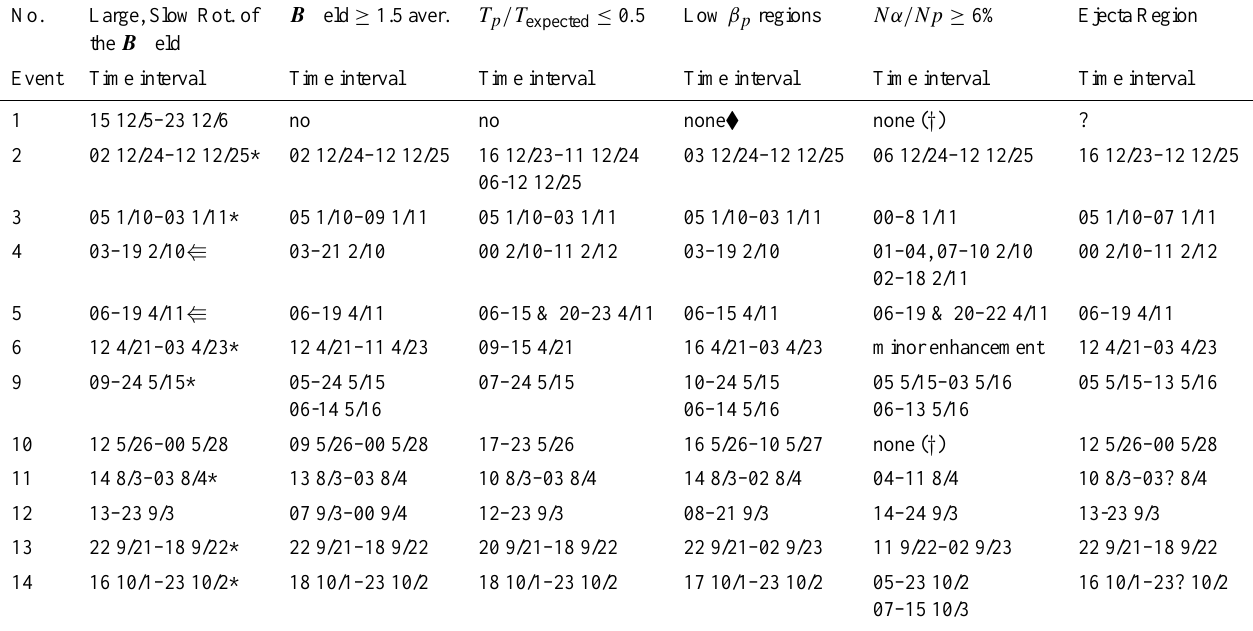
No. Large, Slow Rot. of B field ≥ 1.5